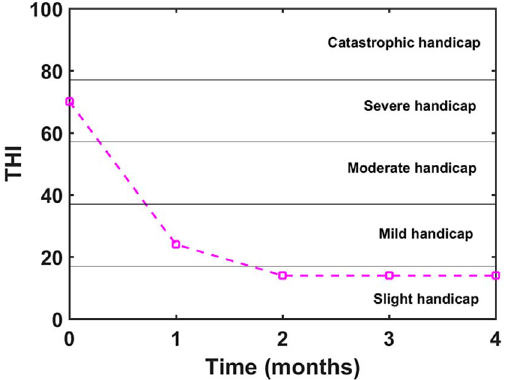
Figure 12. THI time progress of participant #2 along